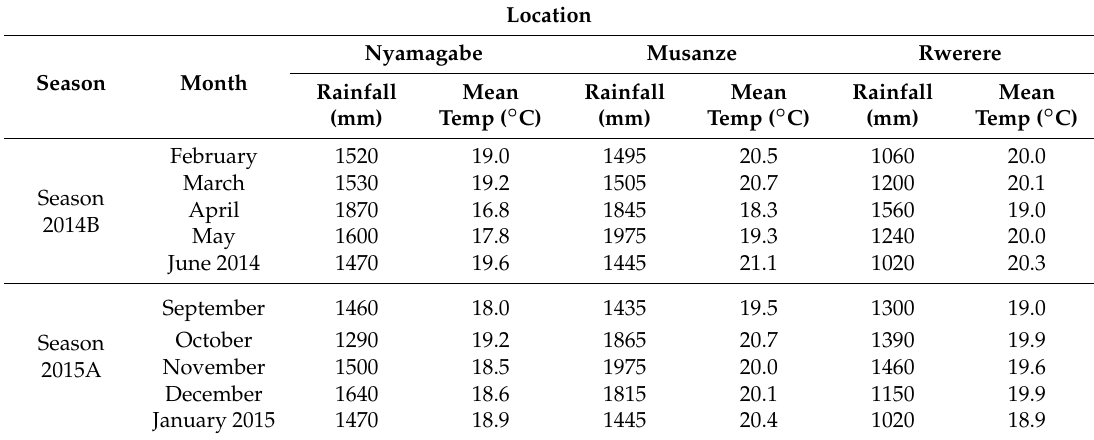
Table 2. Rainfall and mean temperatures of Nyamagabe, Musanze and Rwerere during the experimental period.